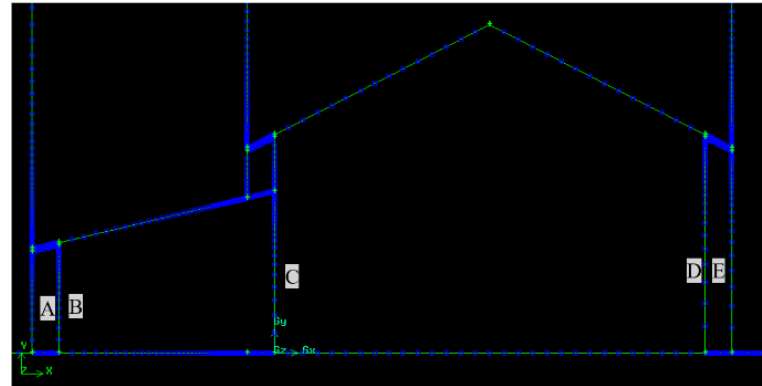
Figure 8. A diagram of the sections generating the grid at the bottom of the computational domain for each section.